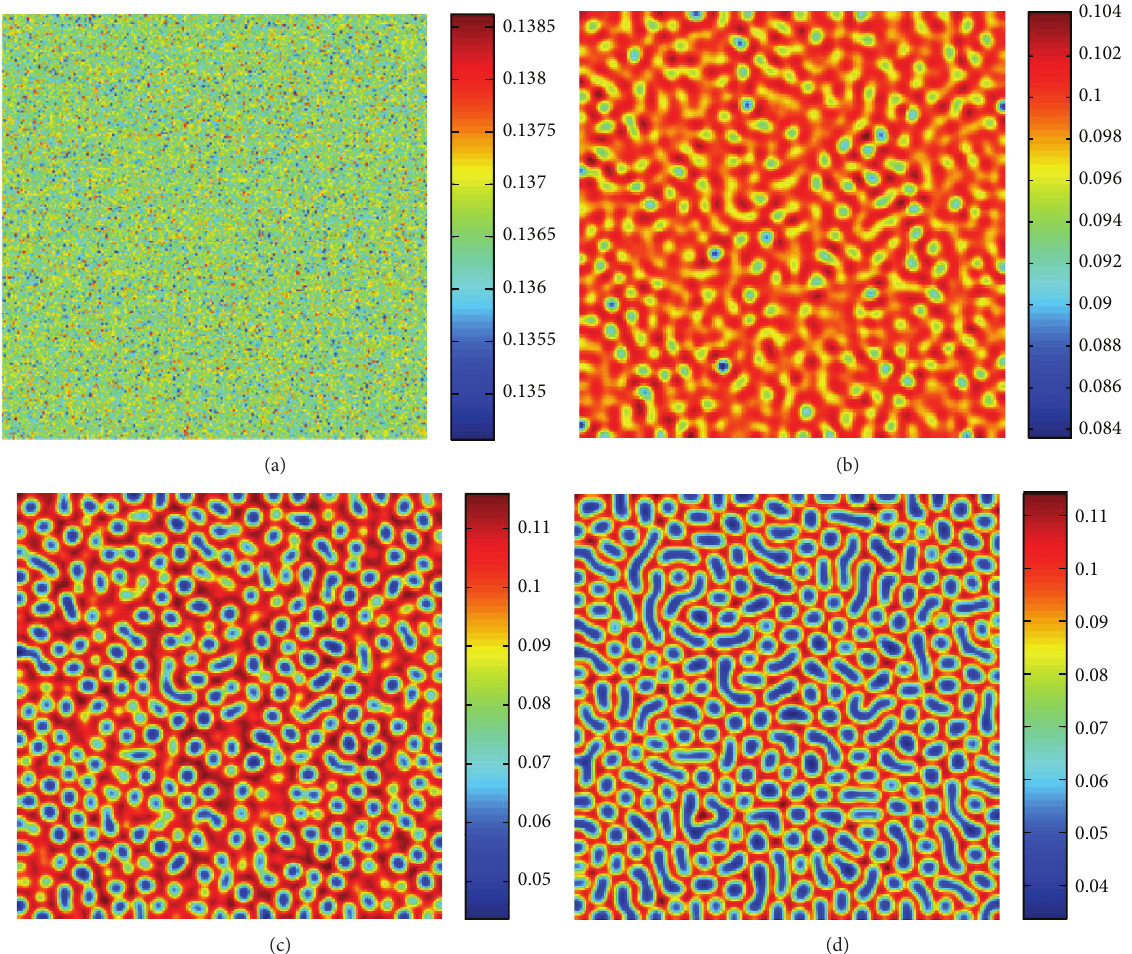
Figure 5: Snapshots of the time evolution of the prey at different instants with 𝛼 = 0 . 6, 𝛽 = 0 . 8, 𝛾 = − 0 . 3, 𝛿 = 0 . 58, 𝜃 = 2 . 2, 𝑑 1 = 0 . 08, 𝑑 2 = 1, and 𝜏 = 0 . 02, which are in the Turing space. (a) 0 iterations; (b) 10000 iterations; (c) 15000 iterations; (d) 100000